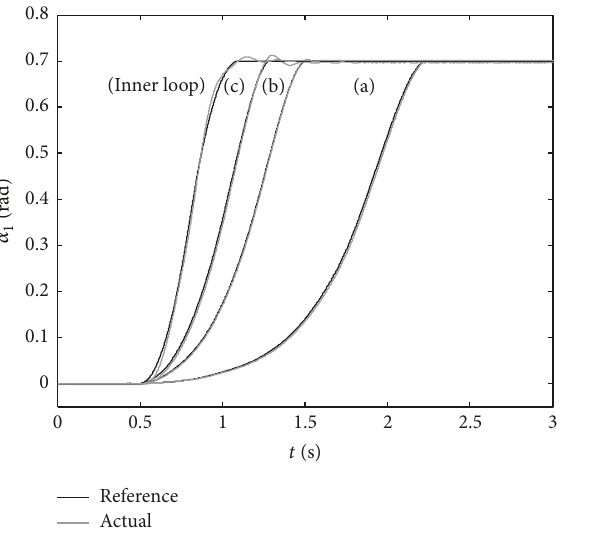
Figure4:Referenceandactualvaluesofthecrankangleversustime.